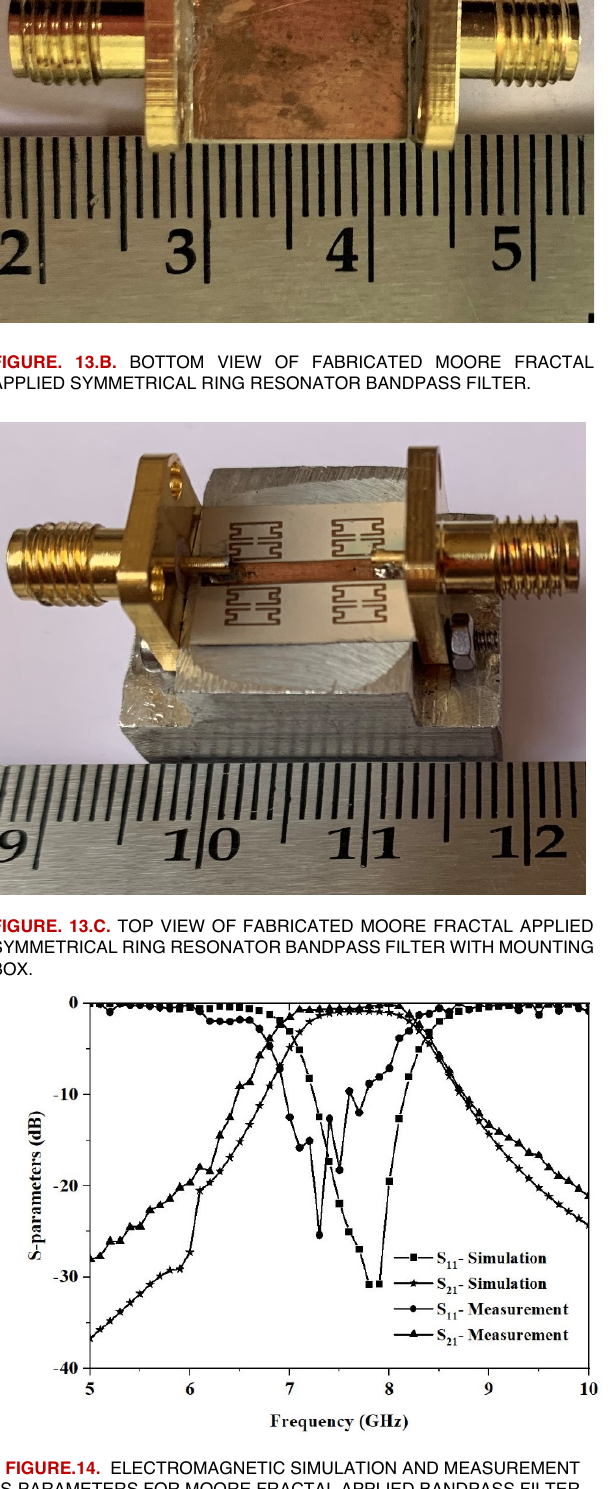
FIGURE.14. ELECTROMAGNETIC SIMULATION AND MEASUREMENT S-PARAMETERS FOR MOORE FRACTAL APPLIED BANDPASS FILTER.